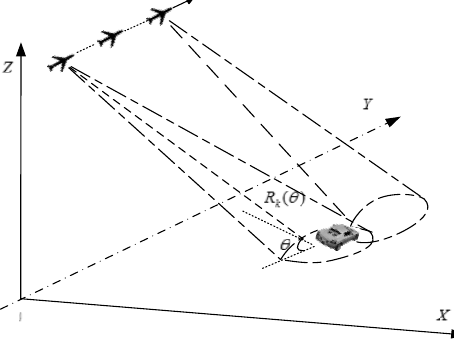
Figure 1. The geometry of the signal model.